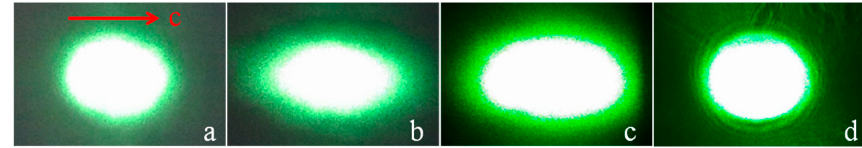
Figure 2. Transmitted laser beam spots of an incident 532-nm wavelength laser after 5 min of irradiation: ( a ) CLN; ( b ) LN: Mo; ( c ) LN: Mo, Hf 2.0 ; ( d ) LN: Mo, Hf 3.5 . The light intensity was 59.3 W/cm 2 for ( a , b ) and 1.54 × 10 4 W/cm 2 for ( c , d ).